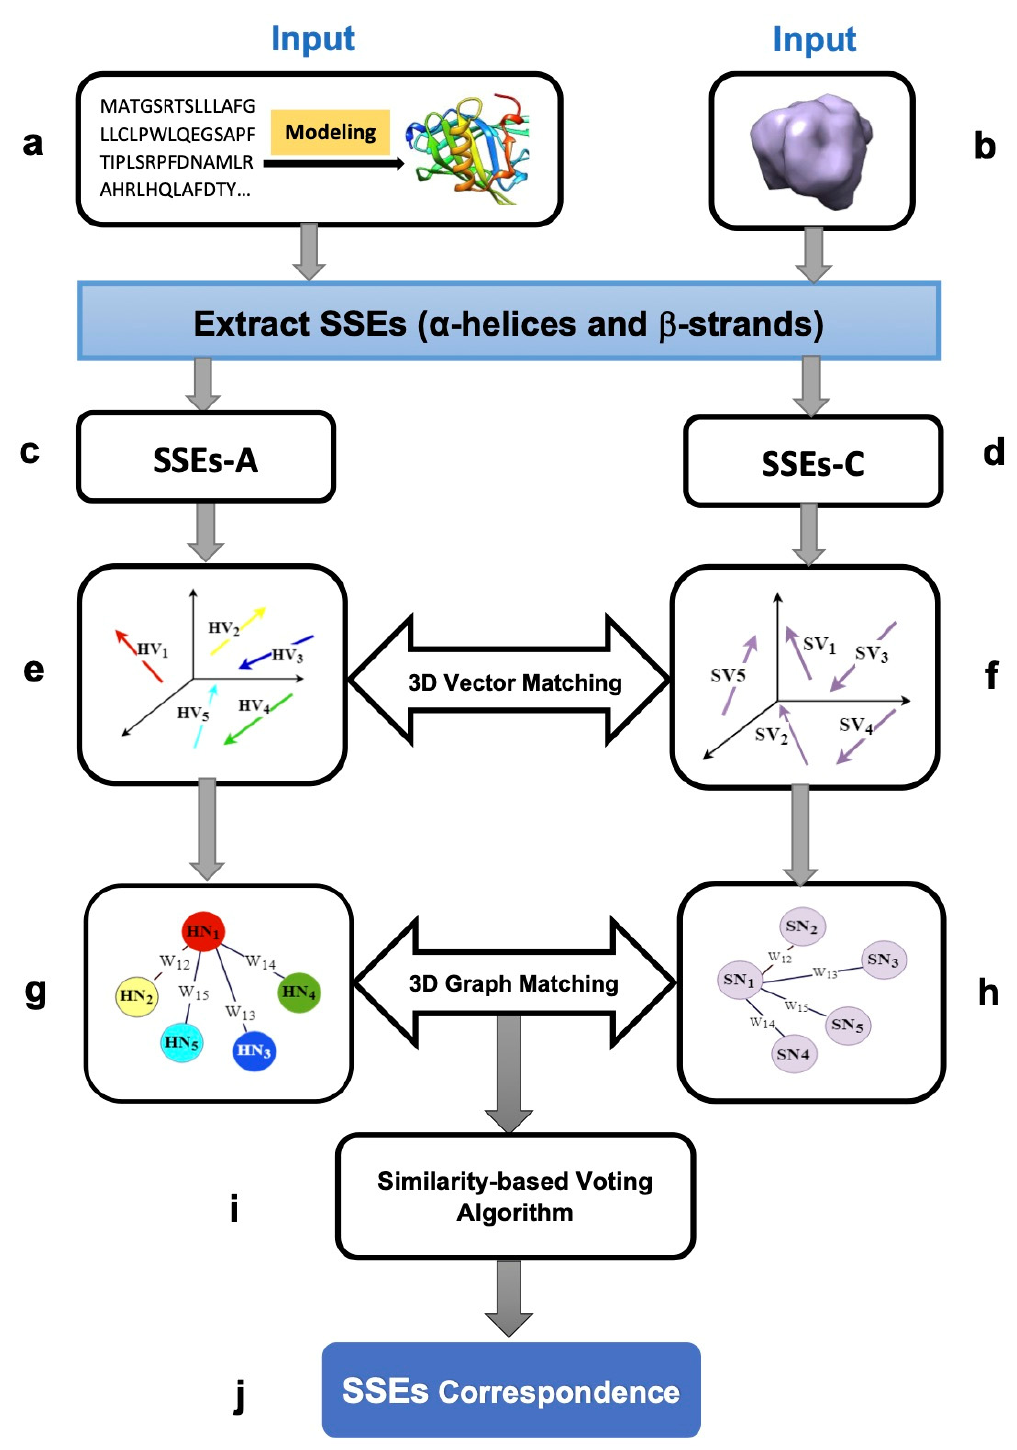
Figure 1. Different stages of the framework pipeline: ( a ) the inputs, including the modeled structure (PDB ID: 1BJ7, chain A) visualized by Chimera [29]; ( b ) the density map simulated at 10 Å resolution using protein structure 1BJ7 and Chimera package [29]; ( c ) the secondary structure elements extracted from the 3D modeled structure in the preprocessing step (SSEs-A); ( d ) the secondary structure elements extracted from the cryo-EM density map (SSEs-C); ( e ) the 3D vectors constructed based on the extracted SSEs-A; ( f ) the 3D vectors constructed based on the extracted SSEs-C; ( g , h ) the 3D graphs are constructed; ( i ) the similarity-based voting algorithm is proposed as a decision making strategy for finding the SSEs correspondence; ( j ) the secondary structure elements correspondence.